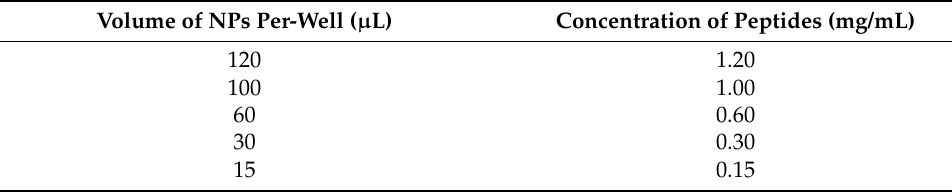
Table 3. Concentration of peptides after several dilutions of peptides-conjugated NPs.